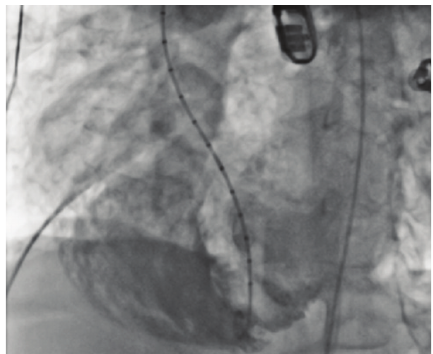
Figure 3: Left ventriculography: shunt of contrast noted.